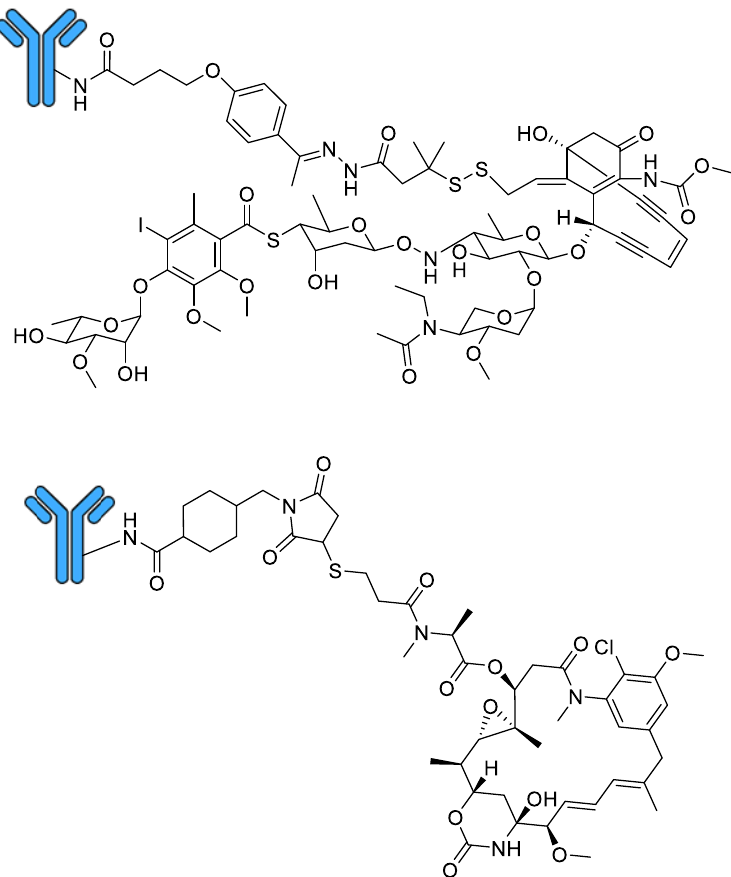
Figure 5. The structure of gemtuzumab ozogamicin (Mylotarg ® , top) and trastuzumab emtansine (Kadcyla ® , bottom) .